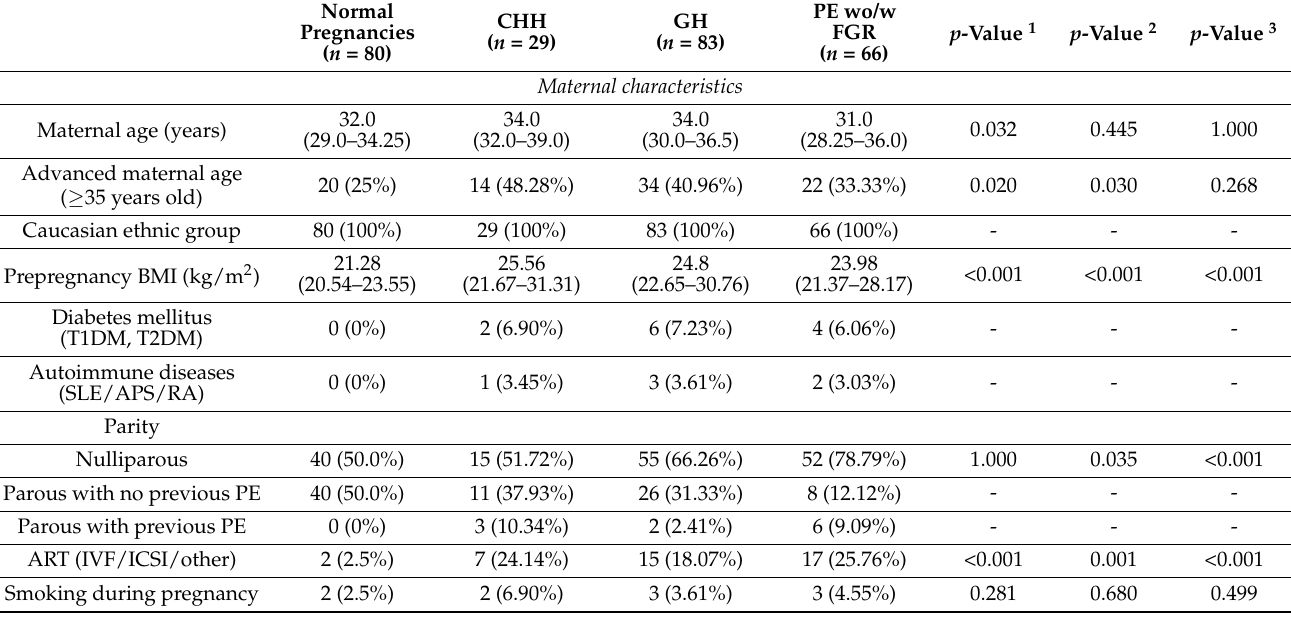
Table 1. Clinical characteristics of the controls and complicated